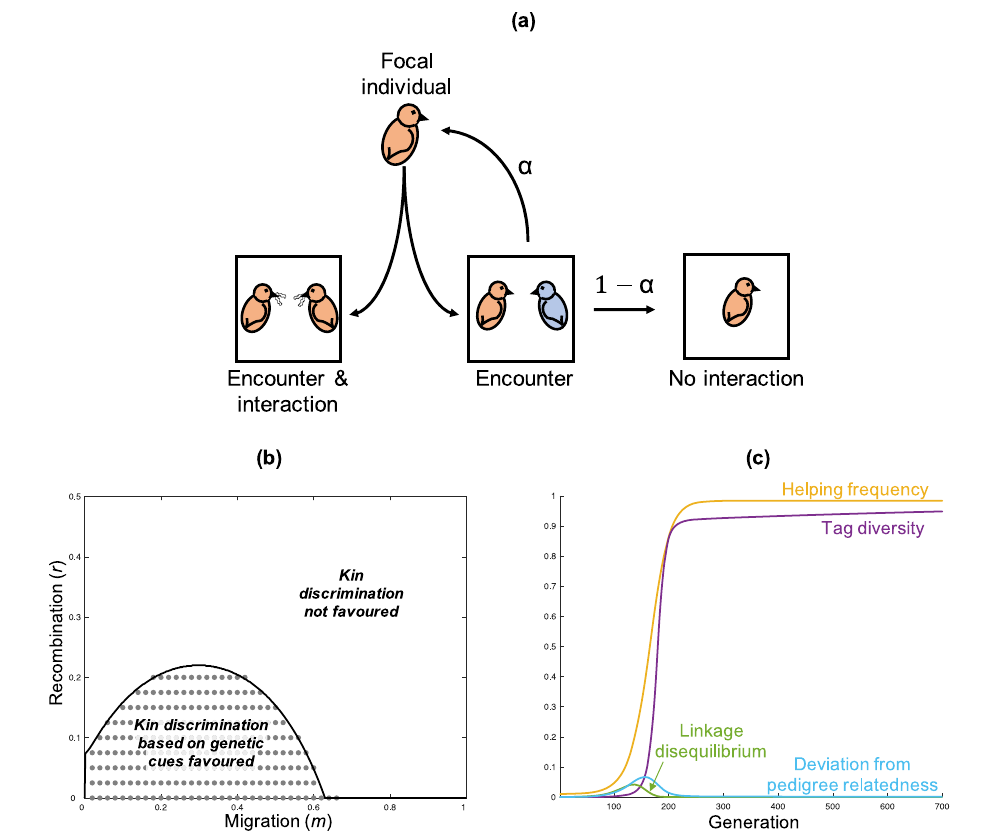
Fig. 2 Stable genetic kin recognition. a Social encounters and social interactions. If the focal individual encounters a tag-matched individual (both orange), it socially interacts. Conversely, if the focal individual encounters a tag-mismatched individual (one orange; one blue), the focal individual may encounter a new partner ( α ), or forgo the social search (1 − α ). Higher values of the encounter parameter ( α ) correspond to individuals having more encounters to fi nd a matching partner. During an interaction with a (tag-matched) partner, the focal individual may help or not (defect), depending upon its allele at the trait locus. b We plot the results of our population genetic island model when encounters are unrestricted and uncostly ( α = 1 & c search = 0). The area under the solid line shows where kin discrimination is favoured by kin selection (Eq. 1 satis fi ed). The data points show parameter combinations where kin discrimination based on genetic cues is stable. These two areas match — whenever kin discrimination is favoured, suf fi cient tag diversity is maintained to allow genetic kin recognition. We assumed µ Trait = 0.001, b = 0.3, c = 0.1, L max = 100, α = 1, c search = 0, N = 30. c An illustrative single trial from panel B with: r = 0.08 ; m = 0.3. Rare tags become statistically associated with helping (linkage disequilibrium increases), which increases relatedness at the trait locus above that expected from pedigree. Consequently, rare tags and helping increase in frequency. As rare tags increase in frequency, they lose their statistical association with helping (linkage disequilibrium decreases), and relatedness at the trait locus converges on that expected from pedigree (see the sections ‘ Derivation of linkage disequilibrium ’ and ‘ De fi nitions of the four outputs plotted in Fig. 2c ’ ; Supplementary Discussion 3). Bird cartoons